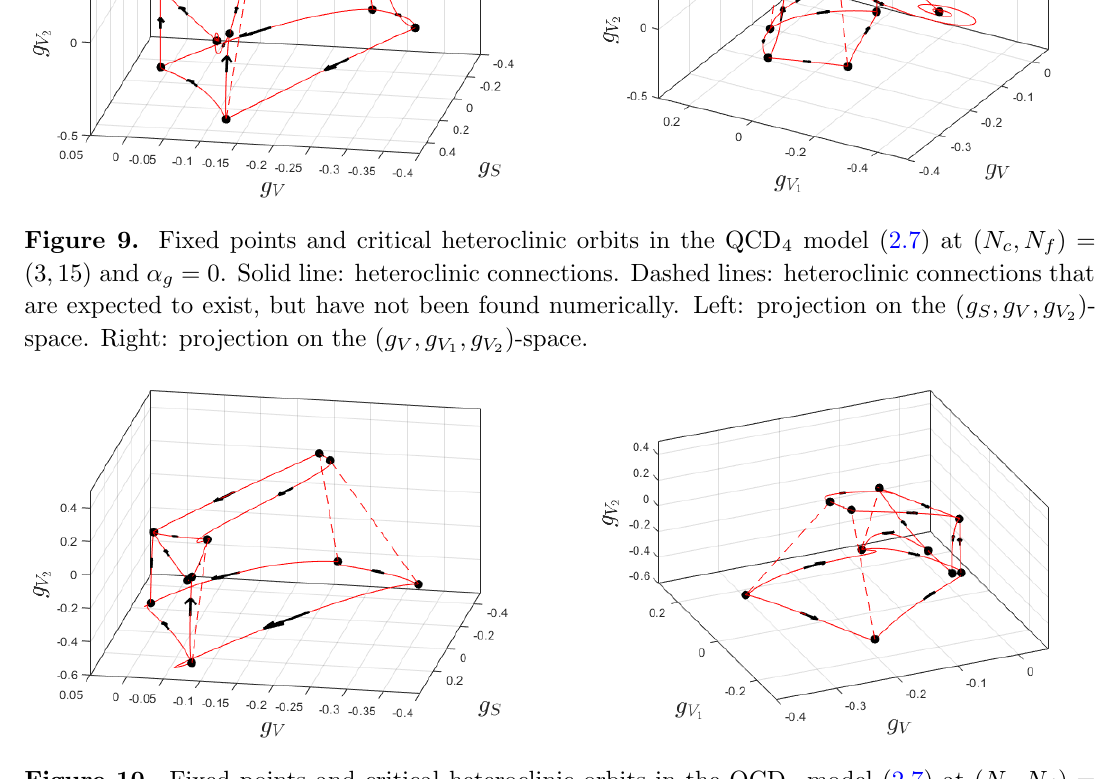
Figure 10. Fixed points and critical heteroclinic orbits in the QCD 4 model (2.7) at ( N c ; N f ) = (3 ; 15) and (cid:11) g = (cid:11) nt . Solid line: heteroclinic connections. Dashed lines: heteroclinic connec- g tions that are expected to exist, but have not been found numerically. Left: projection on the ( g S ; g V ; g V )-space. Right: projection on the ( g V ; g V ; g V 2 1 2